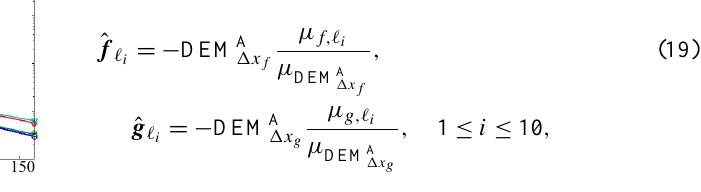
Figure 12. Variation of the mean of POD error ( ¯ e POD ) with respect to M in 2002 and 2006 for multi-site ROM constructed using POD method.